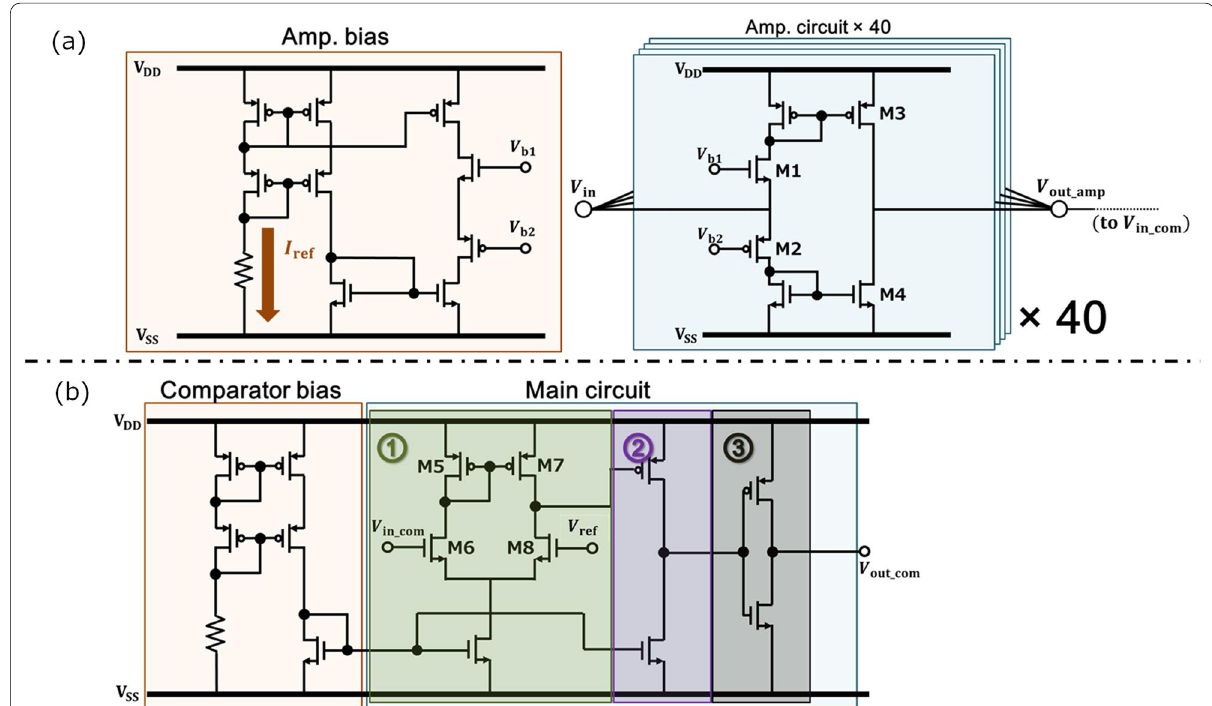
Fig. 5 Schematic diagrams of the current pulse amplification circuit and the comparator. a The current pulse amplification circuit consists of a bias circuit and main amplifier circuits. The input impedance of the main amplifier circuits is set to about 50 Ω. The drive current I ref for the bias circuit is represented by the brown arrow. The bias output ( V b1 and V b2 ) provides the gate voltage to CMOS M1 and M2, which determines the operating point for the amplification circuits. M3 and M4 amplify the input pulse and output signals to the V out_amp terminal. b The main circuit of the comparator consists of three blocks. 1. Differential input circuit (M6 and M8) with an active load (M5 and M7). The V in_com terminal is connected to the output of the current pulse amplification circuit (i.e., “ V out_amp " terminal). The reference voltage for this comparator is applied to the V ref terminal. 2. Amplification stage for improving gain. 3. Inverter as a buffer circuit with low output impedance. The output of the comparator comes from the